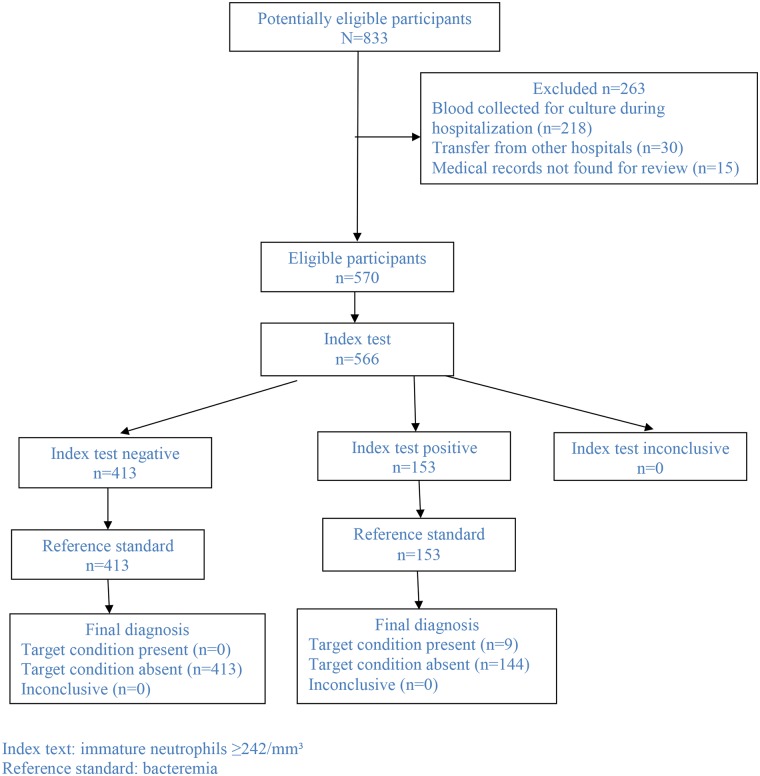
Flowchart of participants through the study.